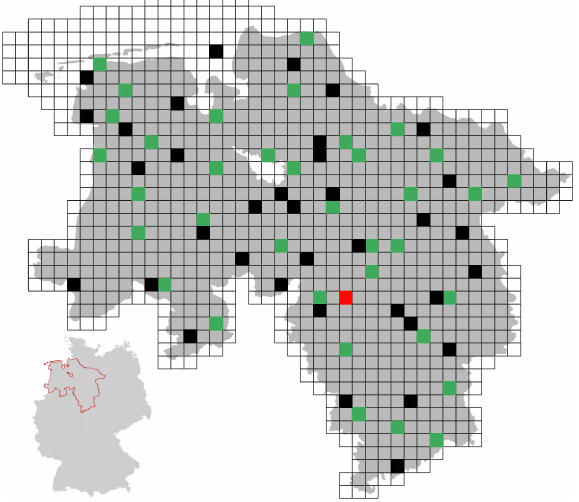
Figure 2. Overview of the available data tiles of 8 × 8 km 2 . Grey / green: potential training / validation tiles. Red: test tile with corrected reference (dataset R 1 ). Black: test tiles without corrected reference (dataset R 2 ).